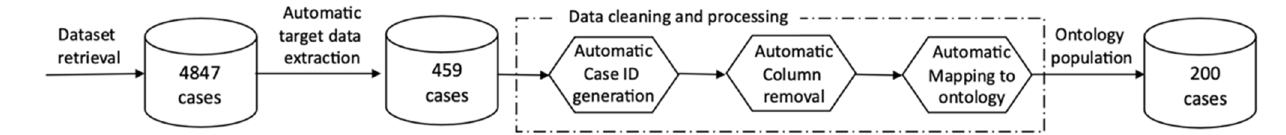
Figure 3. Data extraction and cleaning procedures.